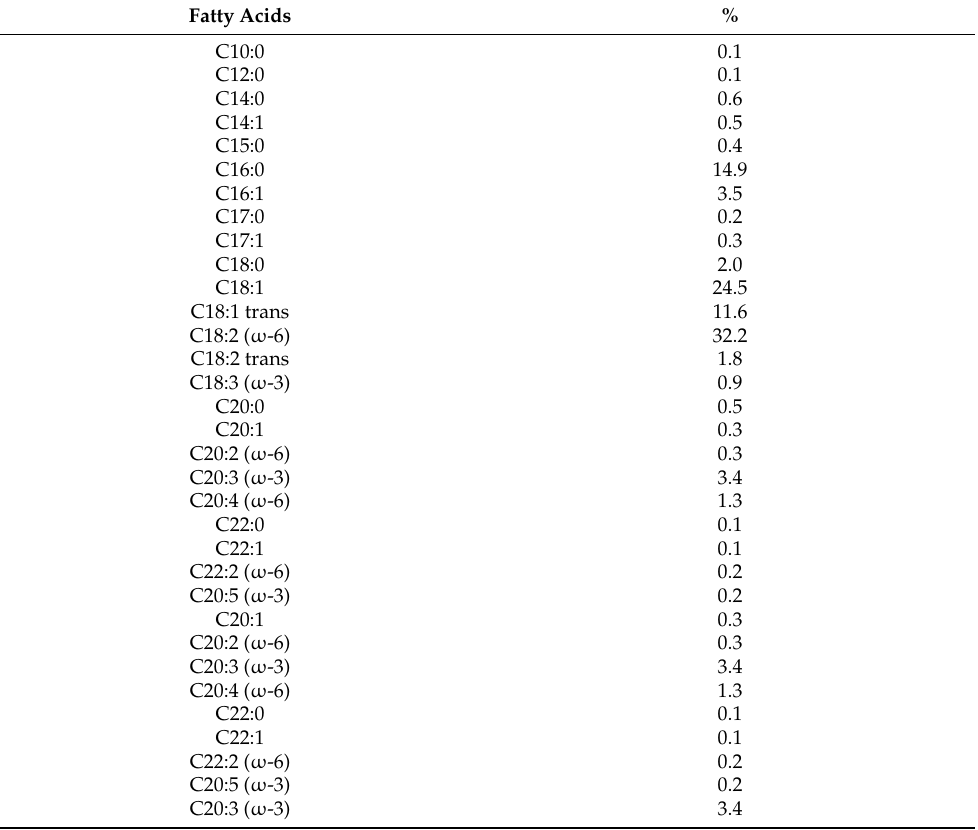
Table 2. Fatty acid composition of triacylglycerides obtained from Ginkgo biloba nuts (crop 2019).